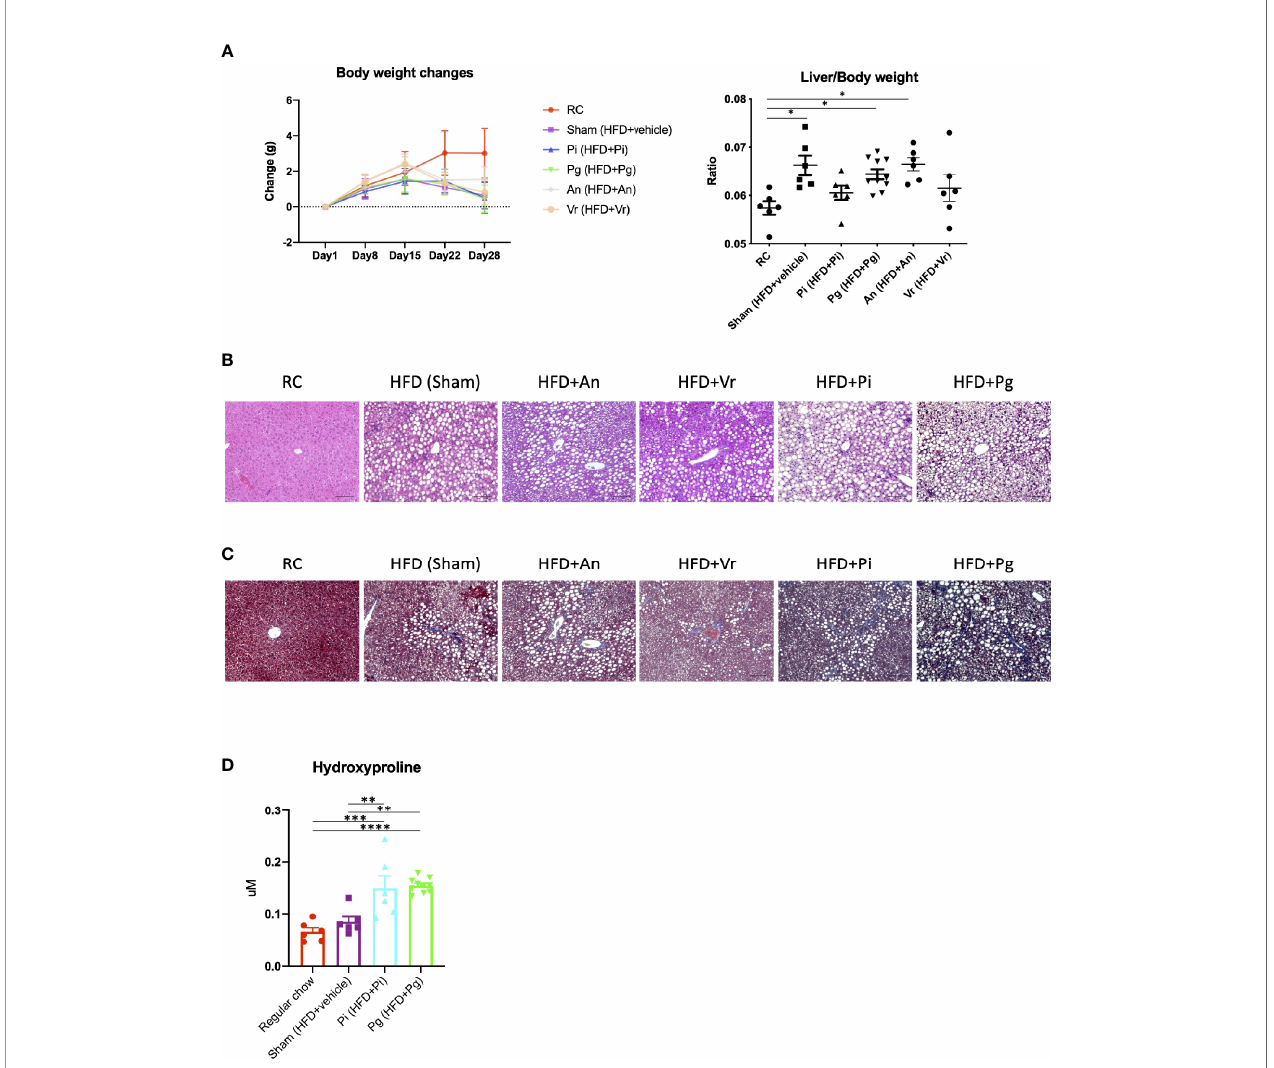
FIGURE 2 | Bacterial administration exacerbates high fat diet-inducedliver pathology. (A) Changes inbodyweight and liver/body weight ratios of mice ineach group during the experimental period. Pi mice hada signi fi cantlylower body weight comparedwith RC mice atday 28 (n=6-10/group). (B) Hematoxylin andeosin staining of liver (scale bars, 100 m m). (C) Masson ’ s trichrome stainingof the liver. (D) Hepaticcontents of hydroxyproline (n=6-10/group). RC: C57BL/6N mice fed regular chow; Sham:Mice fed CDAHFD60 plussham administration; Pi : Mice fed CDAHFD60 plus P. intermedia administration; Pg : Mice fed CDAHFD60 plus P. gingivalis administration, An :